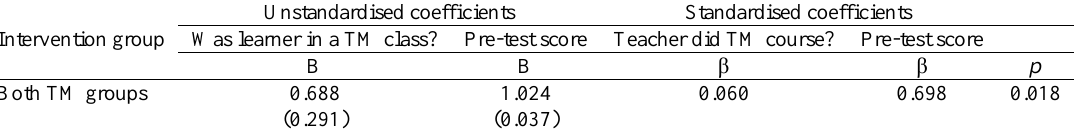
Table 4 Summary of regression analysis for the entire sample of students in comparison to the control. Dependent variable: post-test score. Independent variables: ‘was learner in a TM class?’ and pre-test score. Standard error for unstandardised coefficients shown in brackets.